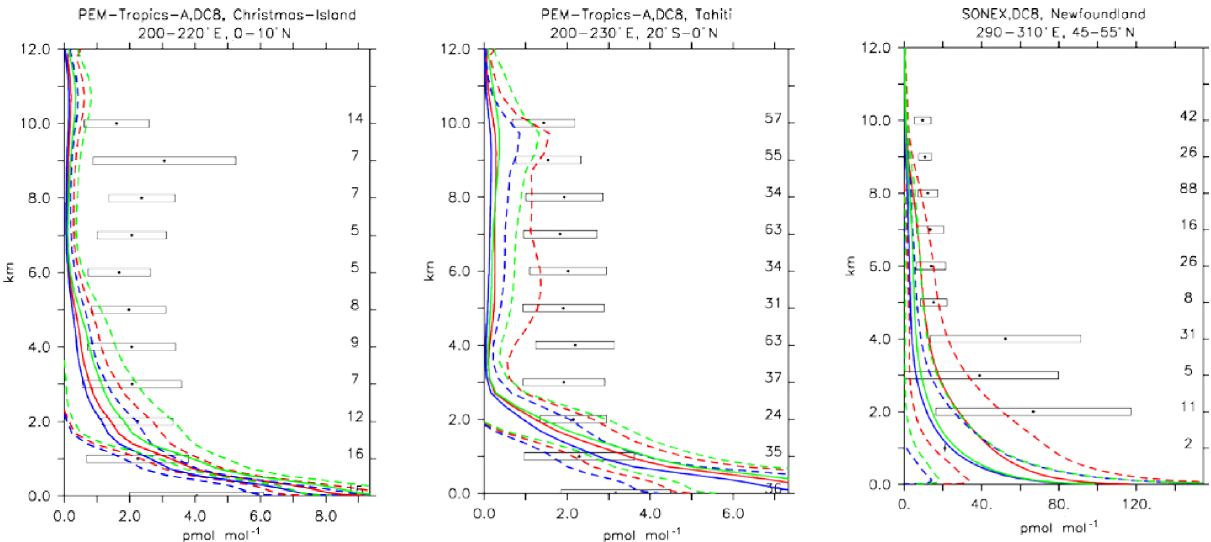
Figure 15. Comparison of simulated C 2 H 4 vertical profiles by using the CBA (red), MOC (blue) and MOZ (green) chemistry versions against aircraft data (black). Line styles and symbols have the same meaning as in Fig. 12.